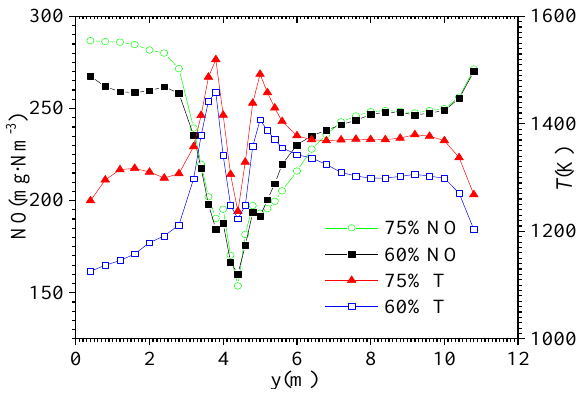
Figure 7. Average gas temperature and NO concentration with boiler height.